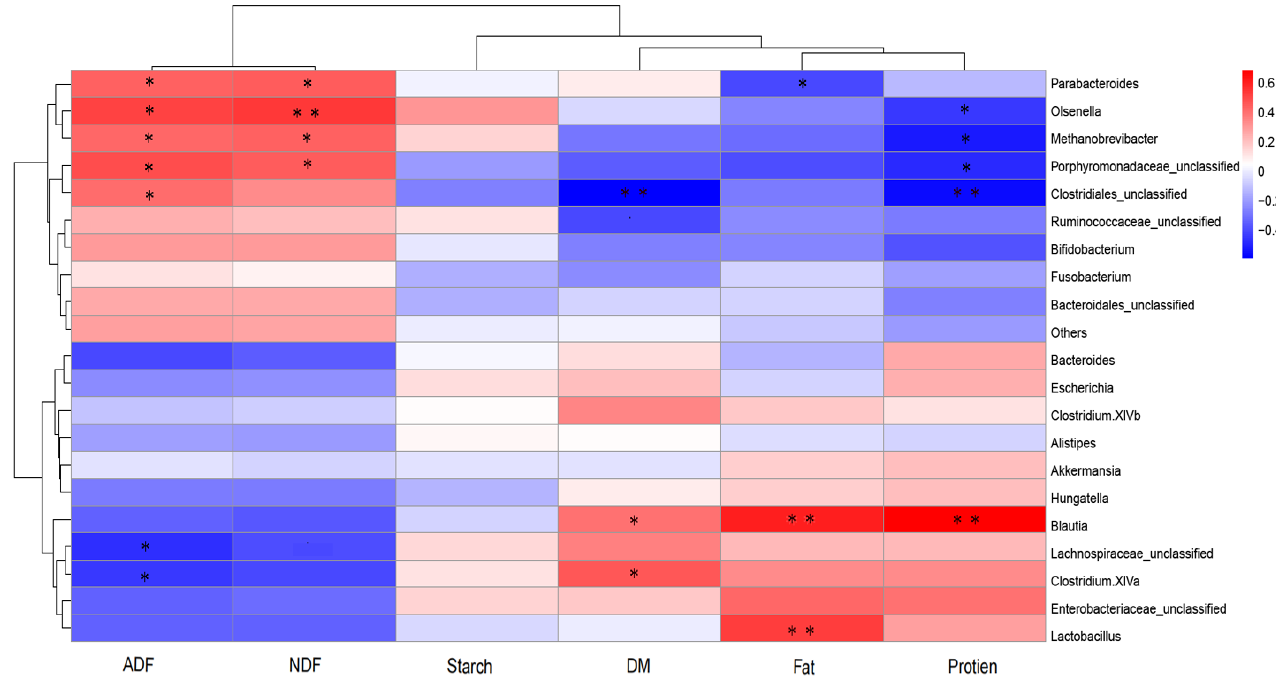
Figure 6. Correlation between the top 20 genus-level taxonomic composition and fecal nutrient contents. Data marked with * indicates a significant correlation ( p < 0.05), and data marked with ** indicates an extremely significant difference ( p <